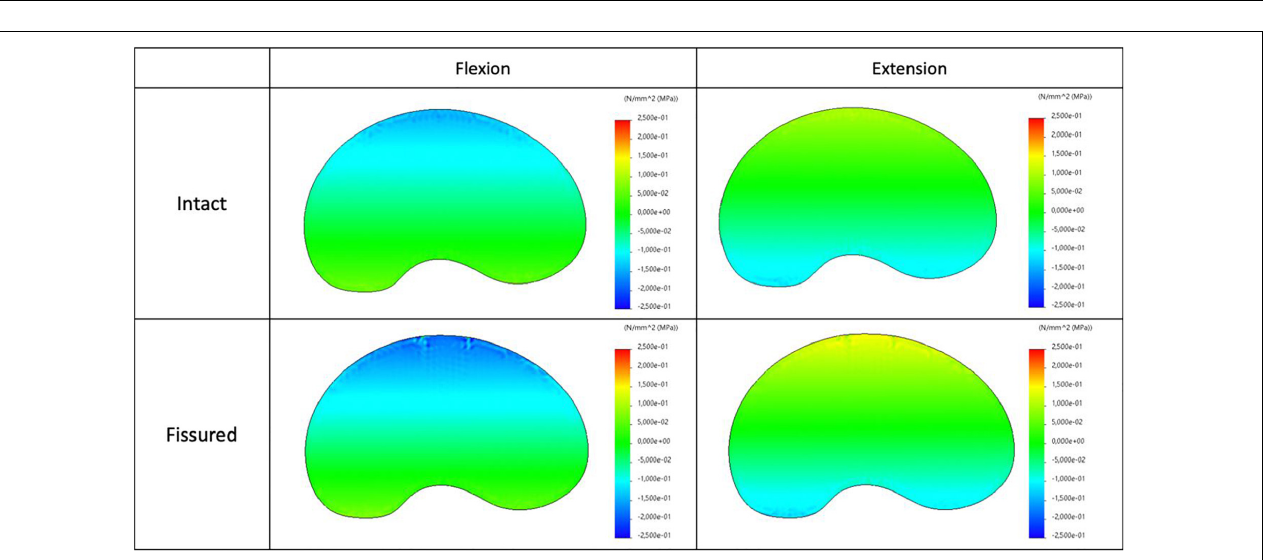
FIGURE 7 | Distribution of the axial stress map for intact (top) and fissured (bottom) disc with flexion (left) and extension (right)